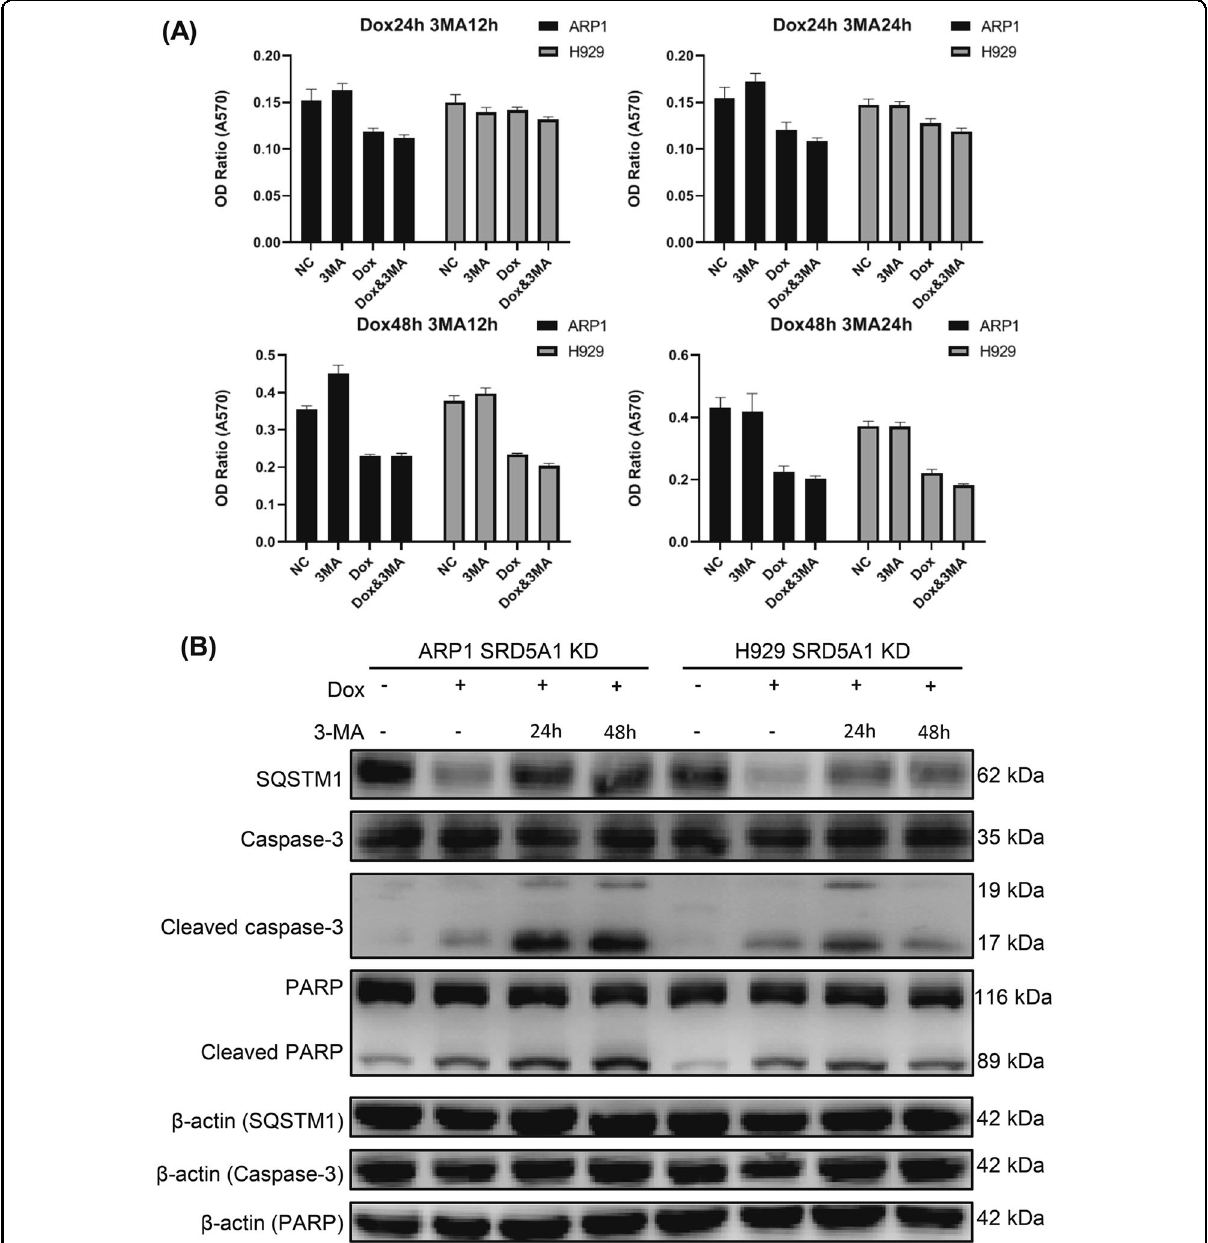
and/or Dox treatment in ARP1- and H929-SRD5A1-KD cells. * P < 0.05, ** P < 0.01, *** P <